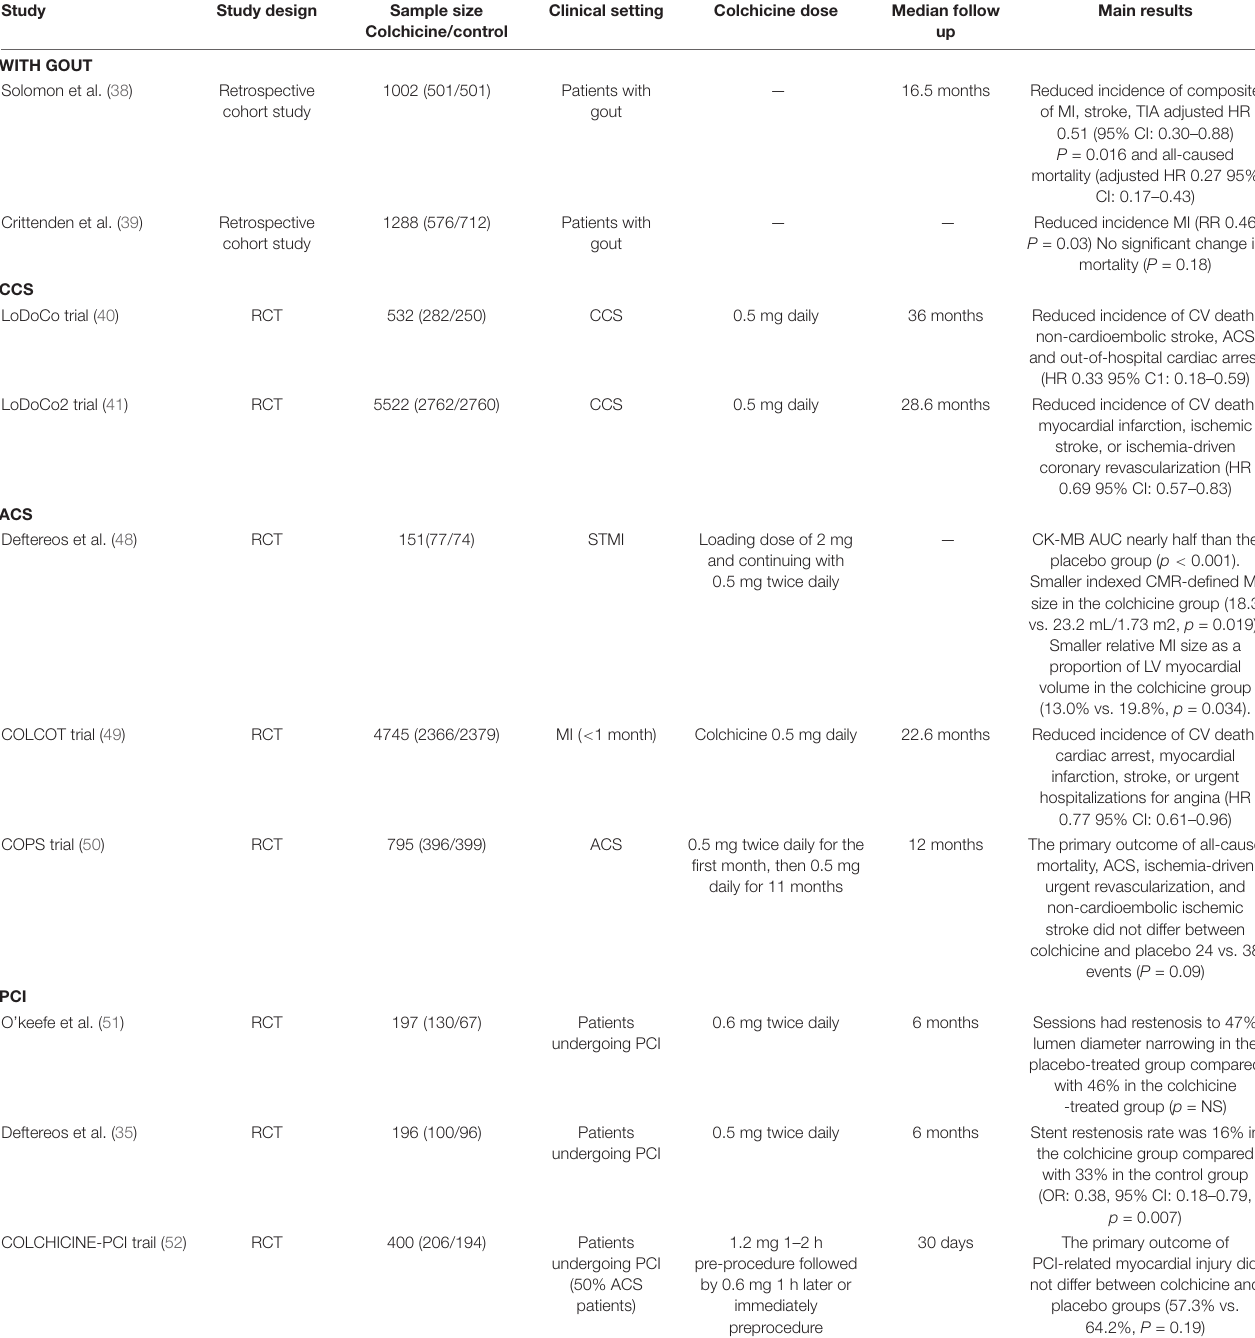
TABLE 1 | A summary of important clinical studies about colchicine in coronary artery